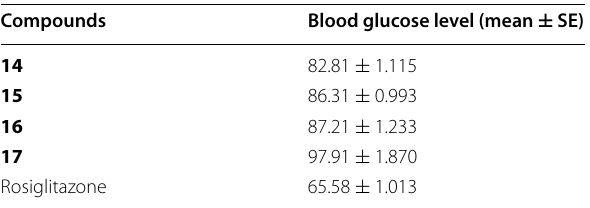
Table 7 Antidiabetic activities of synthesized compounds (mg/dl)